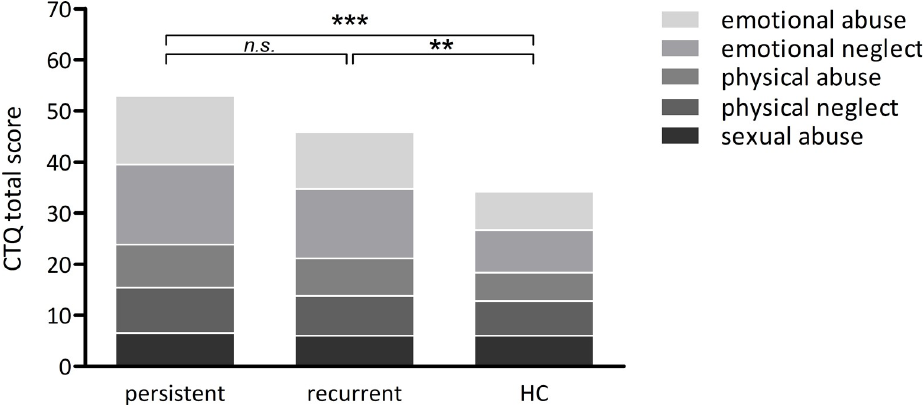
Fig 1. Group means on the amount of childhood traumatization for patients with persistent depression, recurrent depression, and a healthy comparison sample (HC). Asterisks indicate significant group differences concerning CTQ sum scores ( ��� p < .001, �� p < .01, n . s .